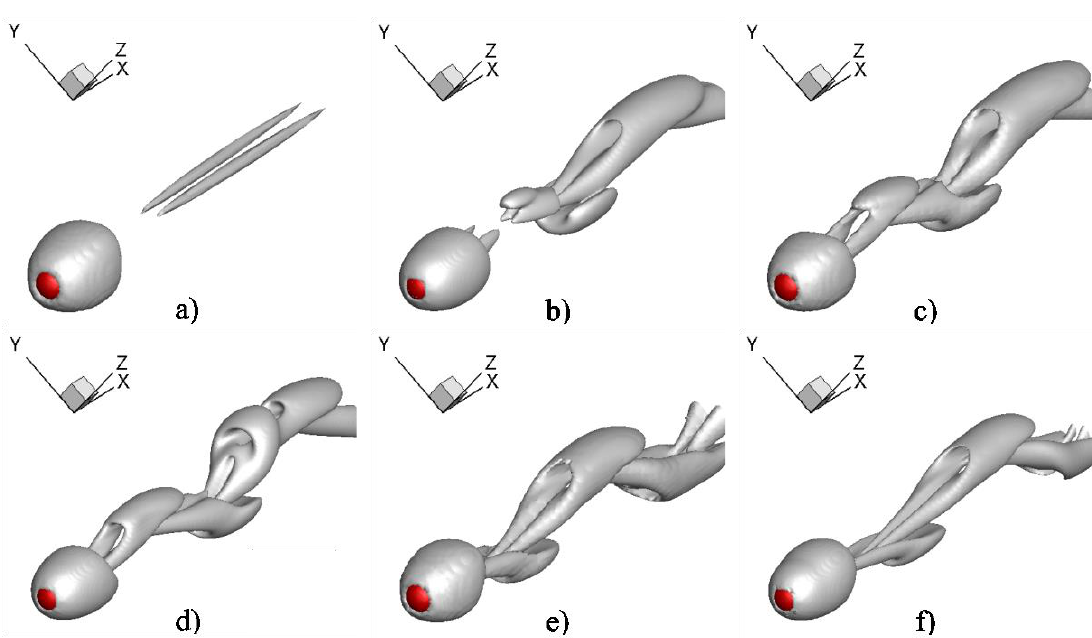
( c ) R300D010S, ( d ) R300D005S, ( e ) R400D010S, ( f ) R400D005S.